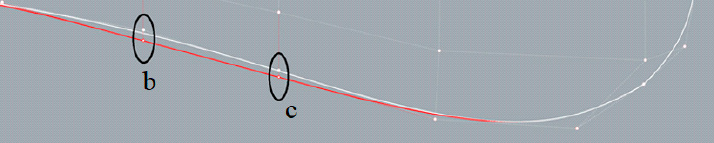
Figure 4. Control point b and control point c in Step (2).